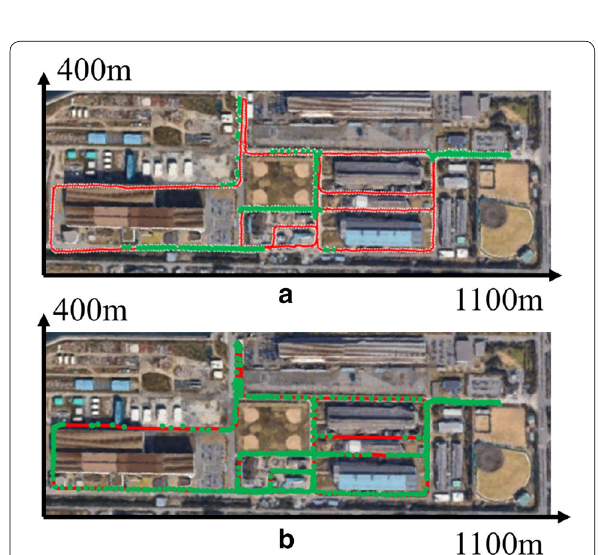
Fig. 15 Red path denotes the robot trajectory and green is the GPS data in a Factory B. a GPS availability of 29.9%: RTK-Fix-GPS; b GPS availability of 59.7%: RTK-Fix-GPS and